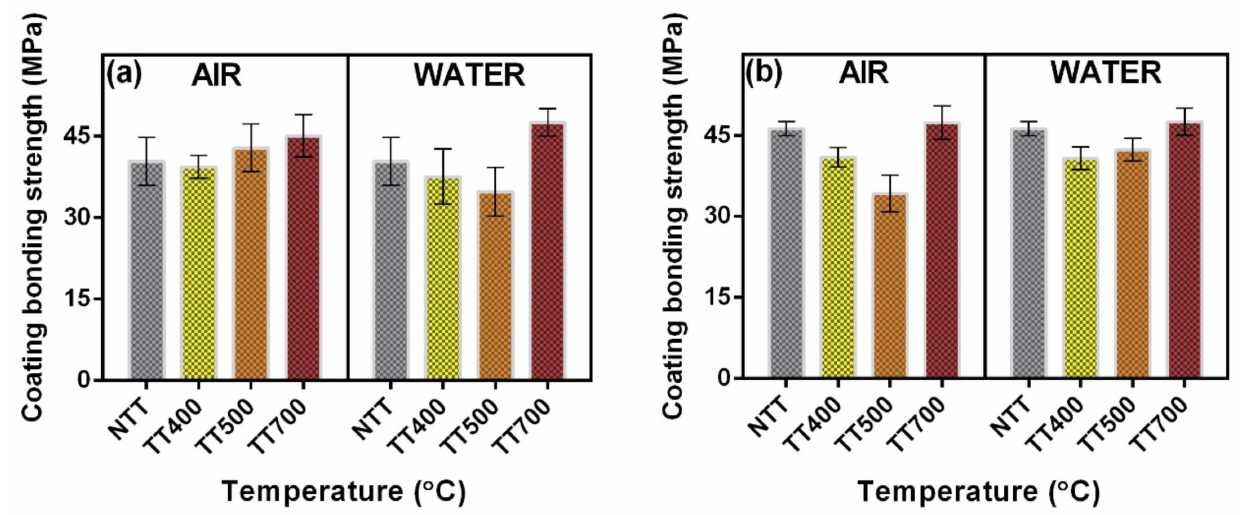
Figure 17. Mean bonding strength values recorded in the case of NTT LiC ( a ) and LiP ( b ) coatings, and of those subjected to post-deposition thermal treatments (at different temperatures), in air and water-vapor